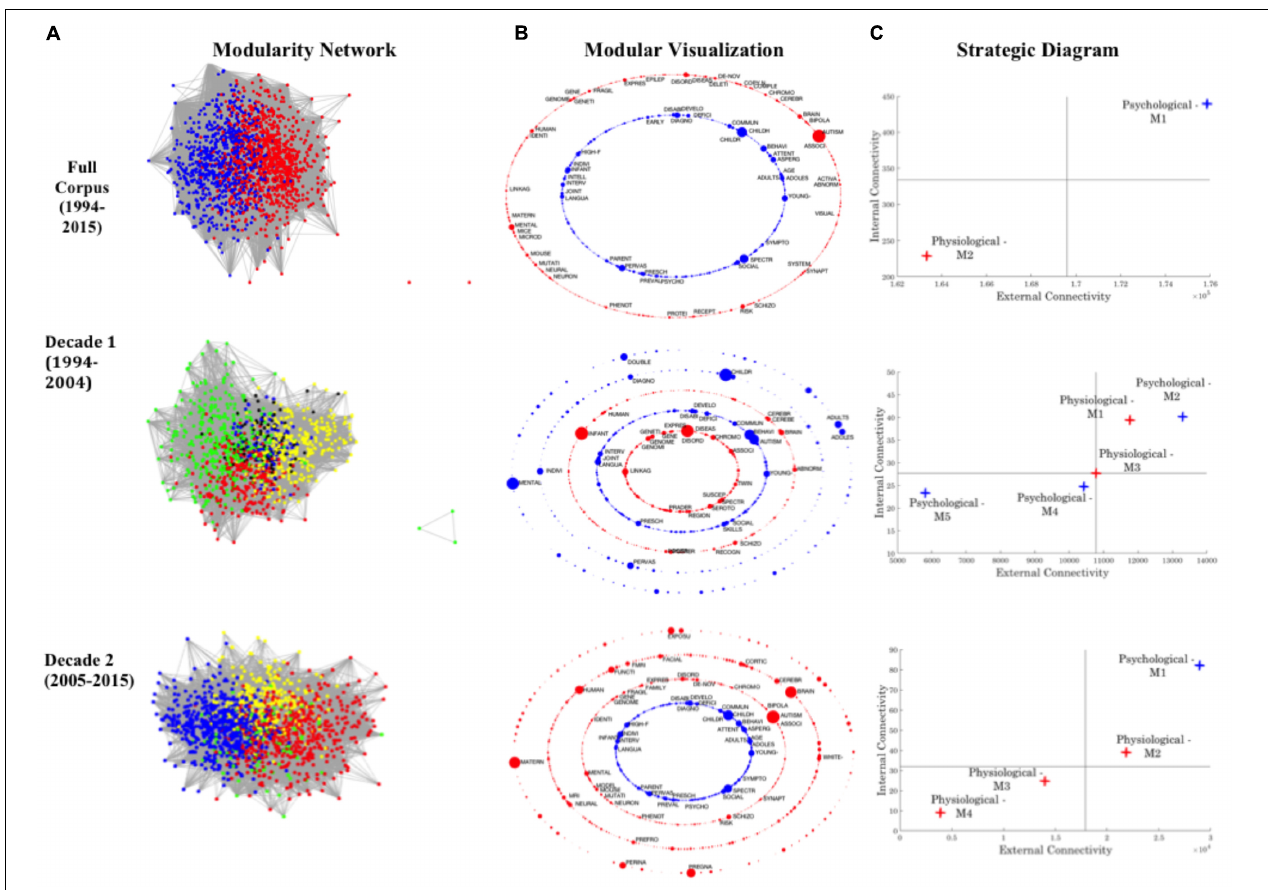
FIGURE 3 | Summary of co-keyword analysis completed across the Full Corpus, and both Decades. (A) Keyword co-occurrence matrices are visualized using graph theory methods, and modularity analytics applied to identify self-clustering modules. These modules are initially visualized within the context of the overarching network, with each highlighted by a block color (e.g., two modules are initially identified at the full decade, while four are identified for Decade 2). (B) To aid accessibility, these modules are visualized as colored concentric rings, each reflecting a module’s singular rank and theme ( Psychological: Blue; Physiological: Red; Green: Interdisciplinary ). Node size reflects normalized Eigenvector centrality – with larger nodes having higher levels of normalized Eigenvector centrality, and thus, empirically assessed as dominant across the module; such prominent internal nodes are labeled (see Supplementary Section 1 for full node listing used for thematic coding). (C) Modular internal and external connectivity metrics were extracted, normalized, and visualized relative to the normalized corpus median values via a strategic diagram. Providing a summary of internal connectivity along the Y-axis, this provides a measure of the cohesiveness of a thematic trend – with highly developed and interconnected themes displaying higher levels of internal connectivity. Summative metrics on the X-axis provide an overview of external connectivity, demonstrating the central dominance of a theme to the research domain. The range of corpus internal and external connections display significant growth between Decade 1 and Decade 2, in line with research proliferation (see Figure 2 ), coupled with simultaneous constriction in modularity, perhaps indicative of the development of cohesive research themes ( Figure 2D )—see Supplementary Table 4 . For yearly (1994, 2006, 2015) assessment see Supplementary Figure 3 . Further, for larger high resolution figures please see https://figshare.com/s/9a0f7b0839fef2df1a6e.